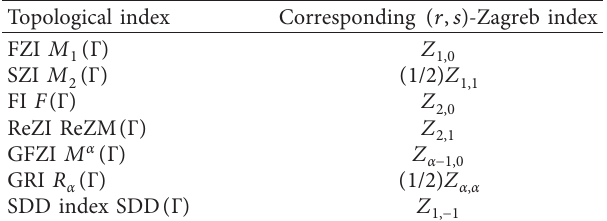
Table 2: Few particular cases of